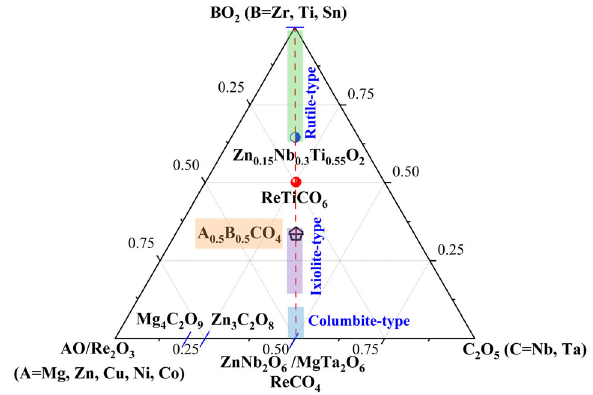
Fig. 4 Pseudo phase diagram of the niobate and